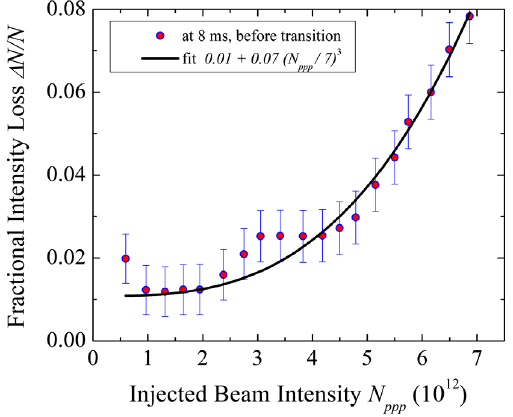
FIG. 6. Intensity-dependent fractional Booster beam intensity loss at injection vs total number of